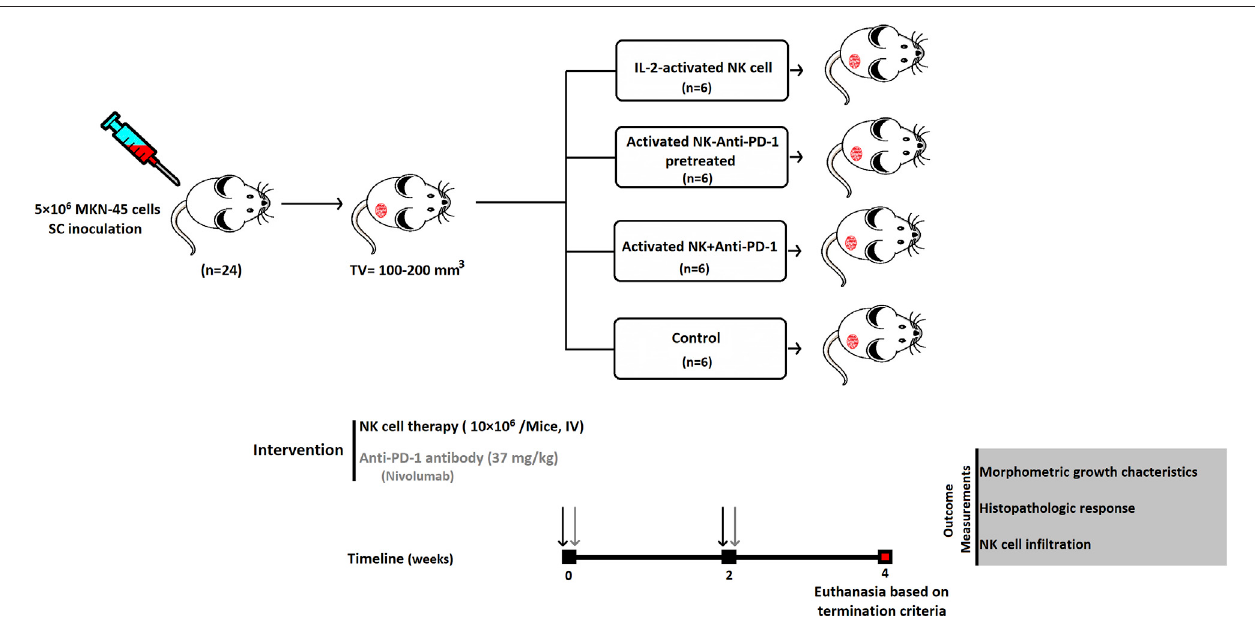
FIGURE 1 | Schematic diagram of anti-PD-1 antibody combined with NK-based immunotherapy in a gastric cancer xenograft model. SC, subcutaneous; IV,